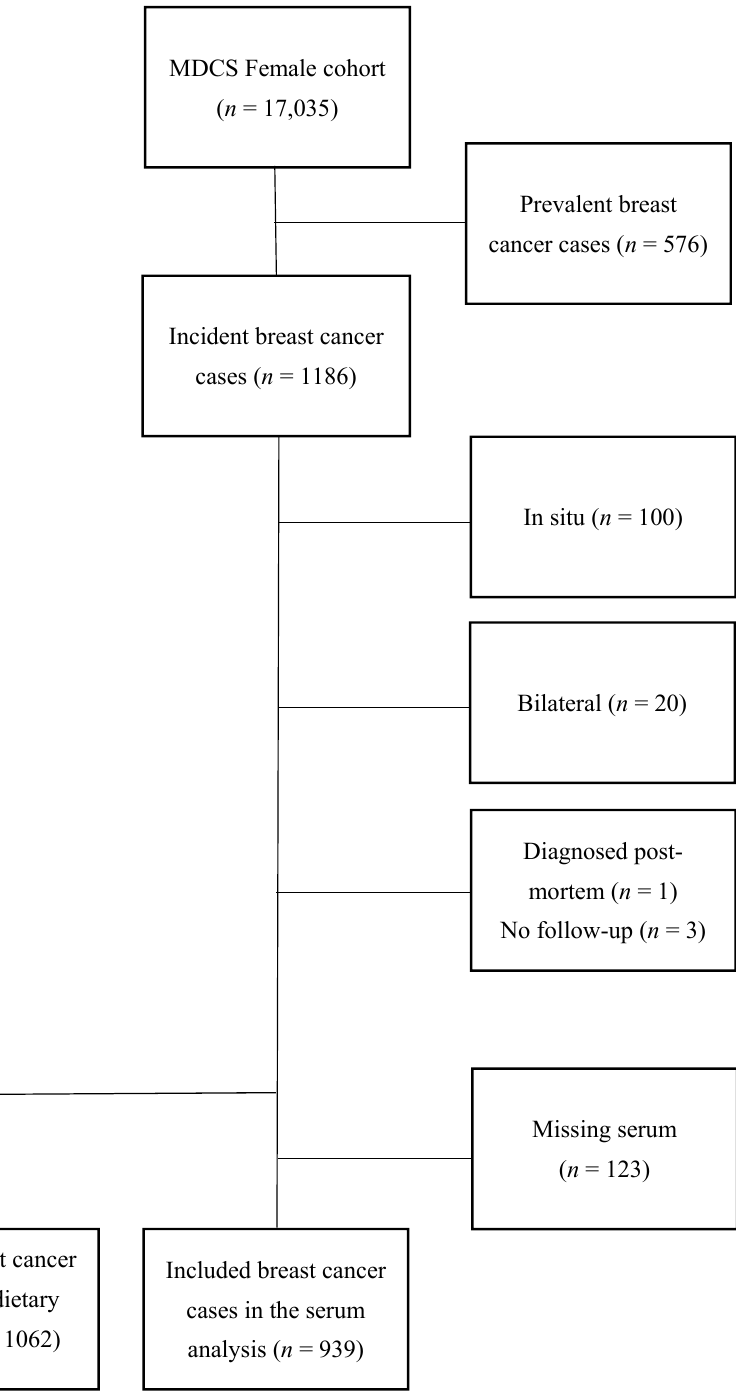
Figure 1. Flowchart of inclusion and exclusion.